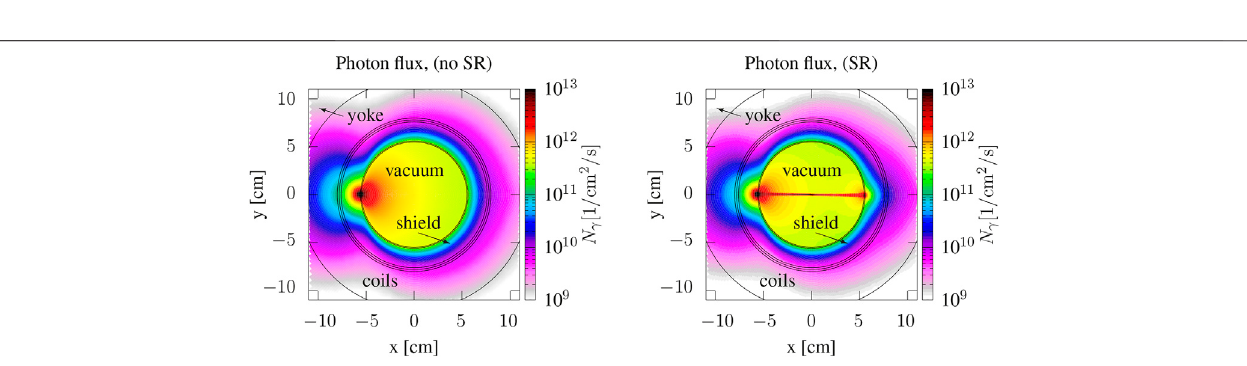
FIGURE5| Comparison inabsoluteunitsbetweenFLUKA(solidcurve)vsexperimental (symbols)[21]double-differential (energyandangle)protonemissioncross sectionfrom 58 Niunderbombardmentwith99.6 MeVdeuterons,resolvedasafunctionoftheprotonenergy E p forthevariousindicatedemissionanglesinthelabframe. The curve for 6 deg emission is in absolute units; subsequent curves have been scaled down respectively by the indicated factors for clarity.